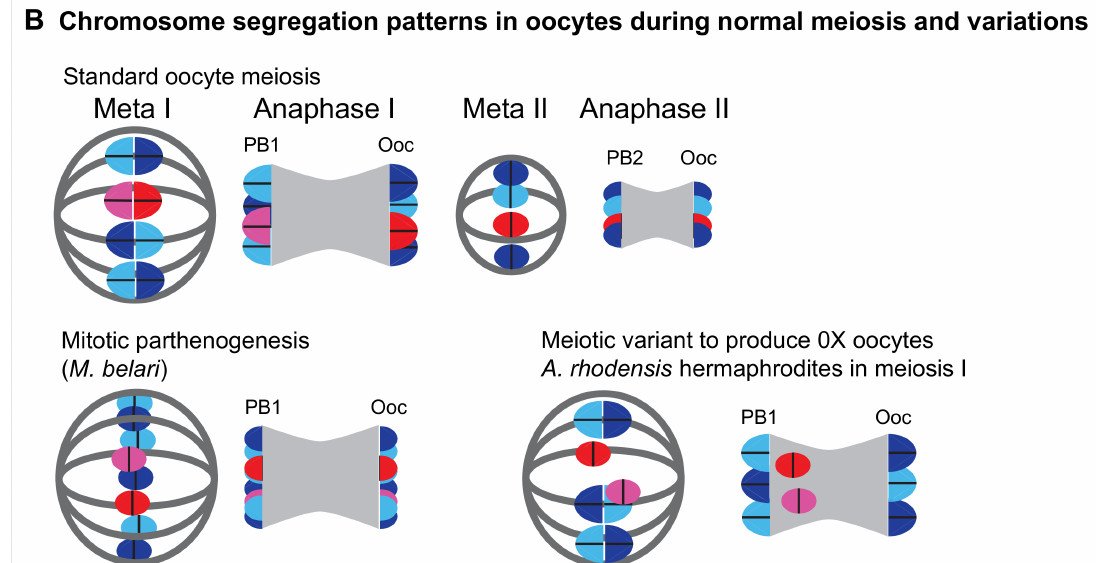
Figure 3. Oocyte meiosis during normal fertilization and parthenogenetic variations. ( A ) Cell-level view ( B ) Enlarged view of chromosomes (blue—autosomes, red/pink—X) and meiotic spindles (gray). ( A —middle) During standard fertilization, the meiotic divisions of the oocyte chromosomes occur only after sperm entry. Oocyte meiosis is associated with acentriolar spindles and during each division, half of the chromosomes are segregated during a highly asymmetric division to a small polar body (PB1, PB2). Homologs separate during the first (reductive) meiotic division, and sister chromatids separate during the second meiotic division (enlarged in B ). During these meiotic divisions, the sperm chromatin(s) remains as a highly condensed, haploid chromatin mass. Following the second meiotic division, the haploid genomes of both oocyte and sperm acquire pronuclear envelopes and undergo a round of DNA synthesis before coming together for the first mitotic division of the embryo. The microtubule asters (green) are formed on sperm-supplied centrosomes. ( A —Variation 1) In Mesorhabditis belari , most sperm enter but their genetic material remains as a tight chromatin mass(es) that does not contribute to the embryo. Instead, the oocyte chromosomes undergo a single, mitotic-like spindle with unpaired homologs (enlarged in B ) to generate offspring that are maternal clones but with sperm-derived centrosomes. When sperm do participate in standard fertilization (gray arrow), the progeny are male, since only Y-bearing sperm participate in fertilization events. ( A —Variation 2) In Meloidogyne hapla , normal fertilization occurs when sperm are present (gray arrow). In the absence of sperm, the oocyte chromosomes undergo the normal sequence of meiotic divisions, but chromosomes from the second division rejoin their sister chromatids (arrow) to generate an embryo with half the genetic diversity of their mother. ( B ) In Auanema rhodensis hermaphrodites, the homologous X chromosomes (red/pink) fail to pair and instead line up as univalents during metaphase I. During anaphase I, both Xs segregate to the polar body, which ultimately results in the production of 0X